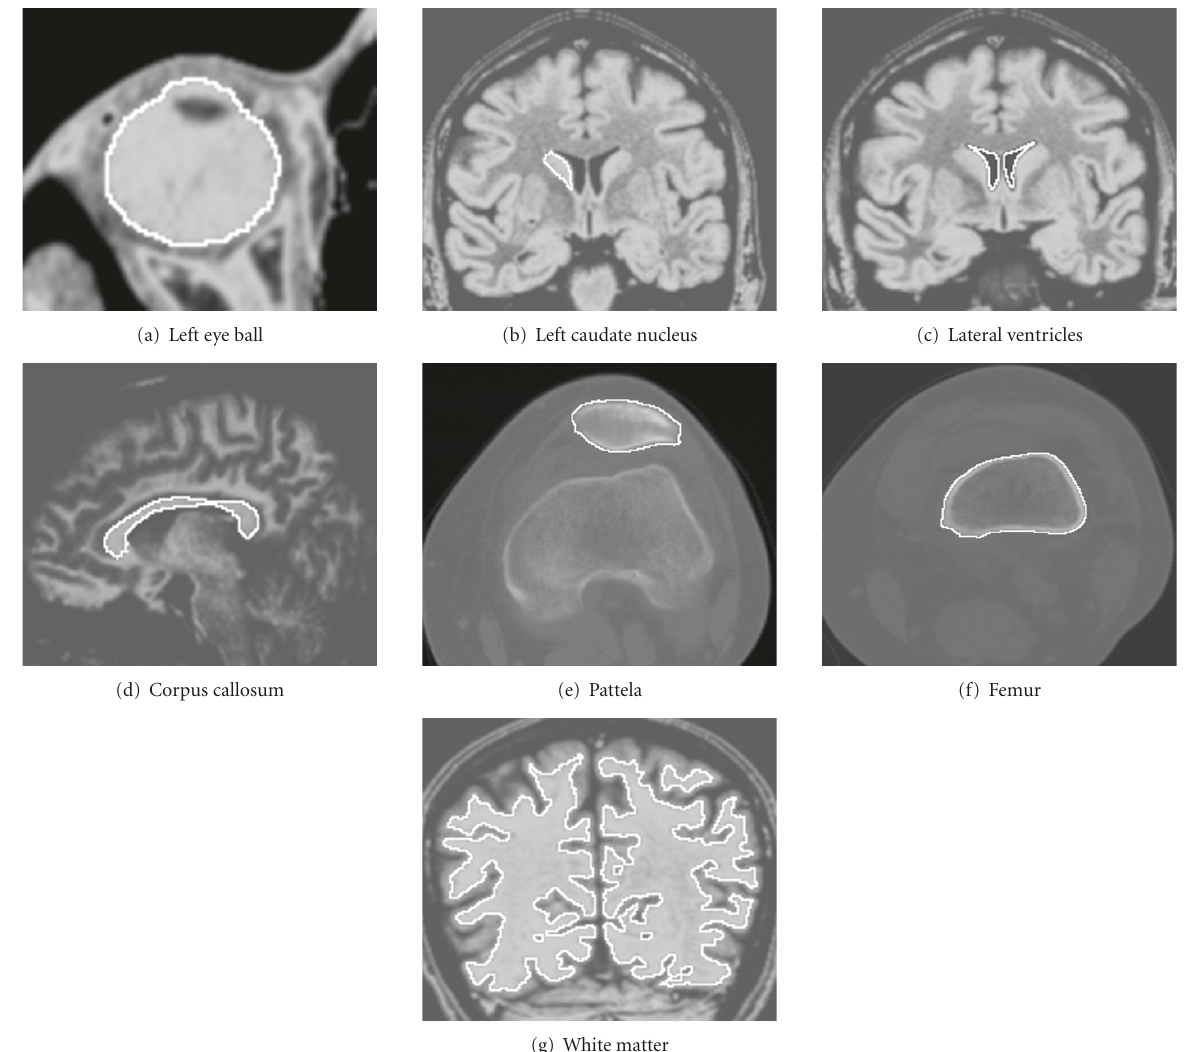
Figure 8: (a)–(g) Results of slice segmentation of the objects from 1 to 7, respectively, overlaid with the preprocessed